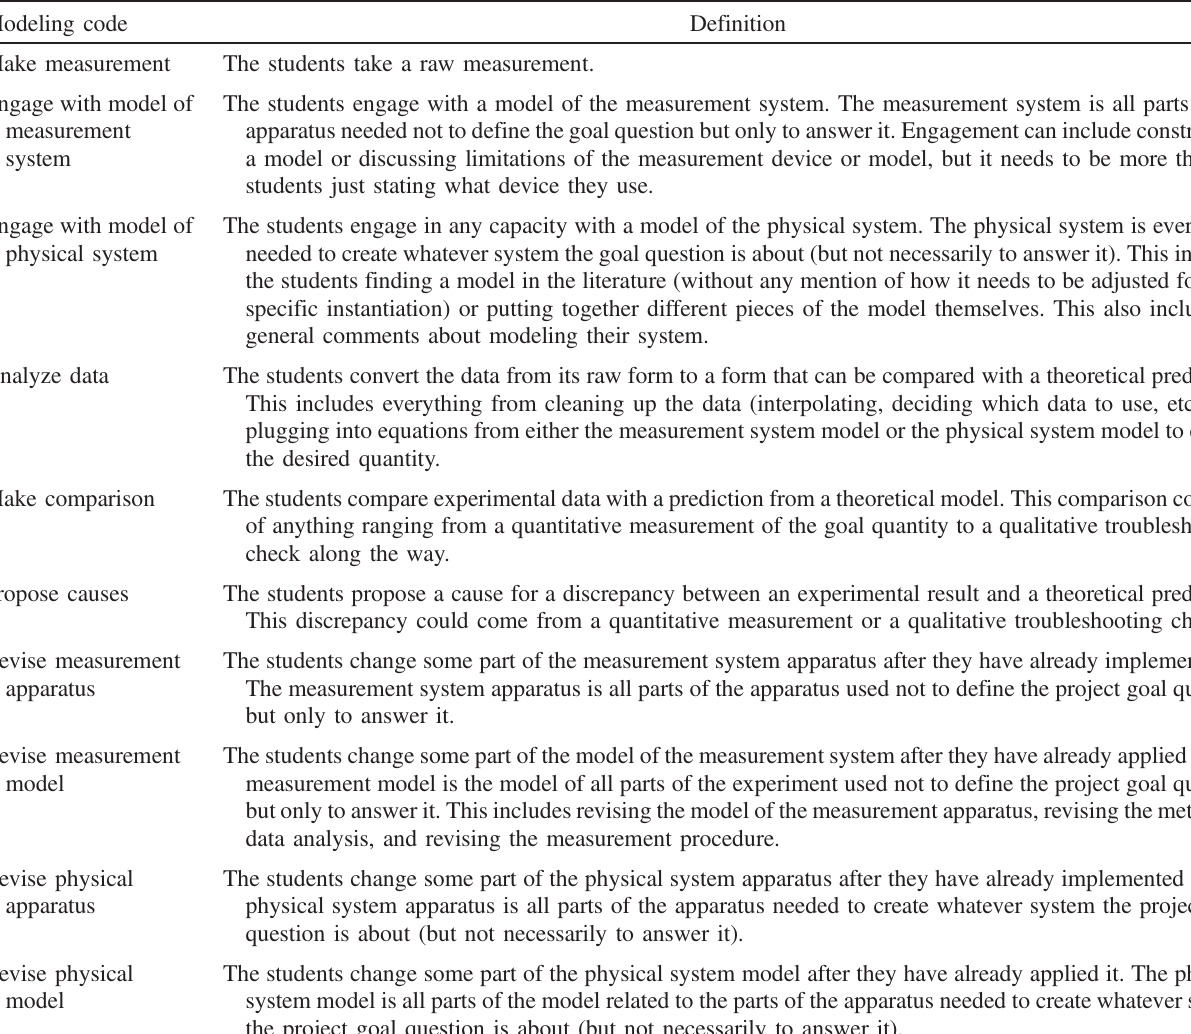
TABLE VI. Codes for the main tasks of the Experimental Modeling Framework and their definitions. These are labeled as “ main modeling codes ” in Fig. 2.